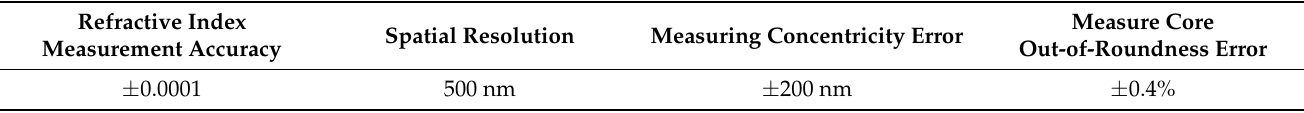
Table 2. Measured parameters of